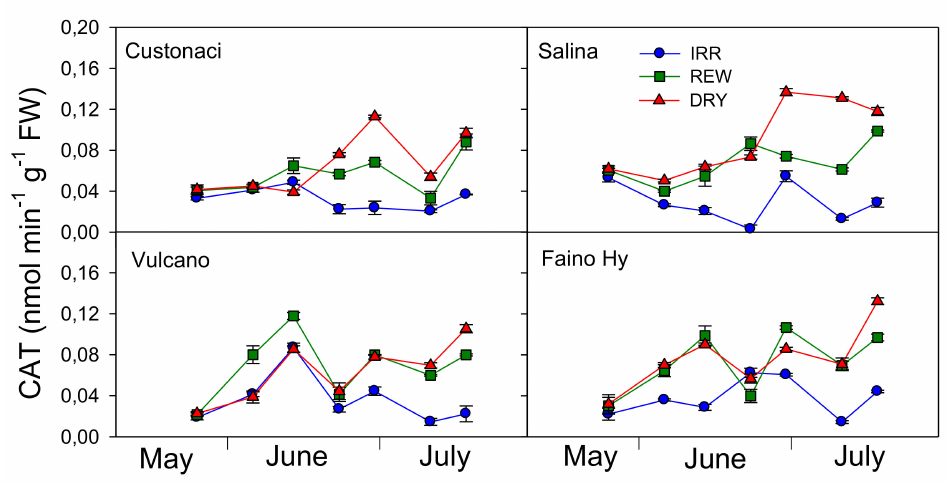
Figure 8. Catalase activity (CAT, nmol min − 1 g − 1 FW) in four genotypes of tomato in relation to the irrigation treatment (IRR: full irrigation; REW: rewatering; DRY: no irrigation). Vertical bars indicate the standard error ( n = 3).